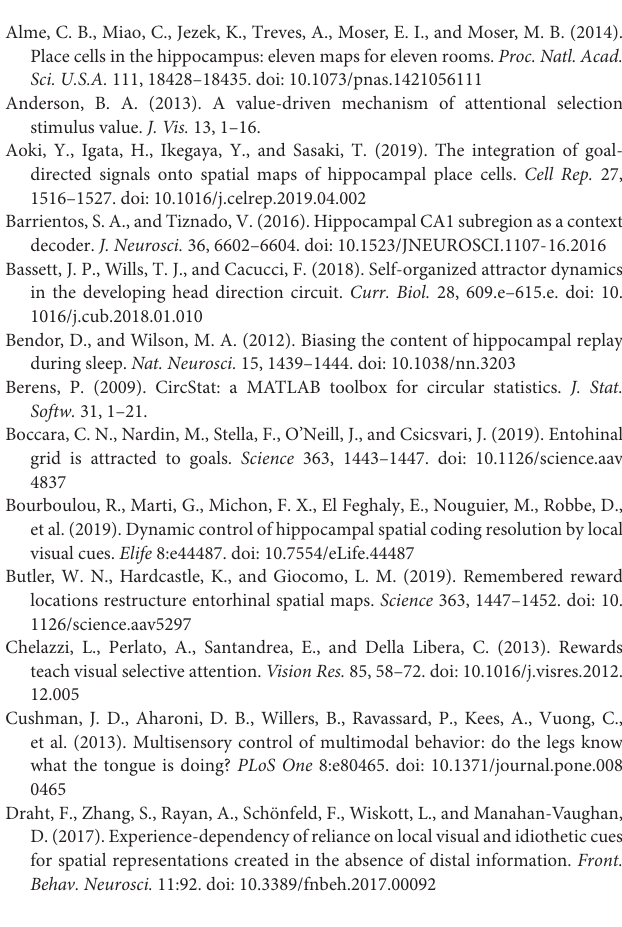
Supplementary Figure 2 | Dynamic and coherent representation in the CA1 in the RwdFlav paradigm. (A,B) The amount of rotation of firing fields of all the active place cells in all the ensembles in the CCW group (the red circle), the CW group (the green circle), and the AR group (the blue circle) between STD vs. MIS sessions, represented around the circle. (C,D) The amount of rotation of firing fields of all the active place cells in all the ensembles in the CCW group (the red circle), the CW group (the green circle), and the Stay group (the blue circle) between STD vs. STD sessions, represented around the circle. The direction of arrow represents the mean angle of rotation of population of neurons in each group, and length of the arrow signifies the compactness of the distribution around the mean angle. The brown line indicates the rotation angle of reward flavors (R) and distal cues (D) in MIS sessions (circle; open = 1 cell, filled = 5 cells). Values of mean angle of the distribution, 95% confidence interval, length of the mean vector (r) and its significance level (p) are shown near to each plot. Supplementary Figure 3 | (A) Histogram of the peak firing position of the place cells in all the sessions obtained by linearizing the track and binning the track into 72 bins (5 ◦ per bin). The dotted line indicates the position of the spokes. U, B, and C indicate the spokes that provided the unflavored, banana-flavored, and chocolate-flavored pellets. (B) Chi-Square values for each session when compared with expected values. Supplementary Figure 4 | Density scatter plots of the mean direction of place cell pairs after spatial cross-correlation of co-recorded neurons between adjacent sessions in Tex ( N = 344), Tex + Rwd ( N = 643), RwdMag ( N = 1,305), and RwdFlav ( N = 5,288) experimental paradigms. In the color map, blue indicates 0, and red indicates the maximum number of cell pairs in a given